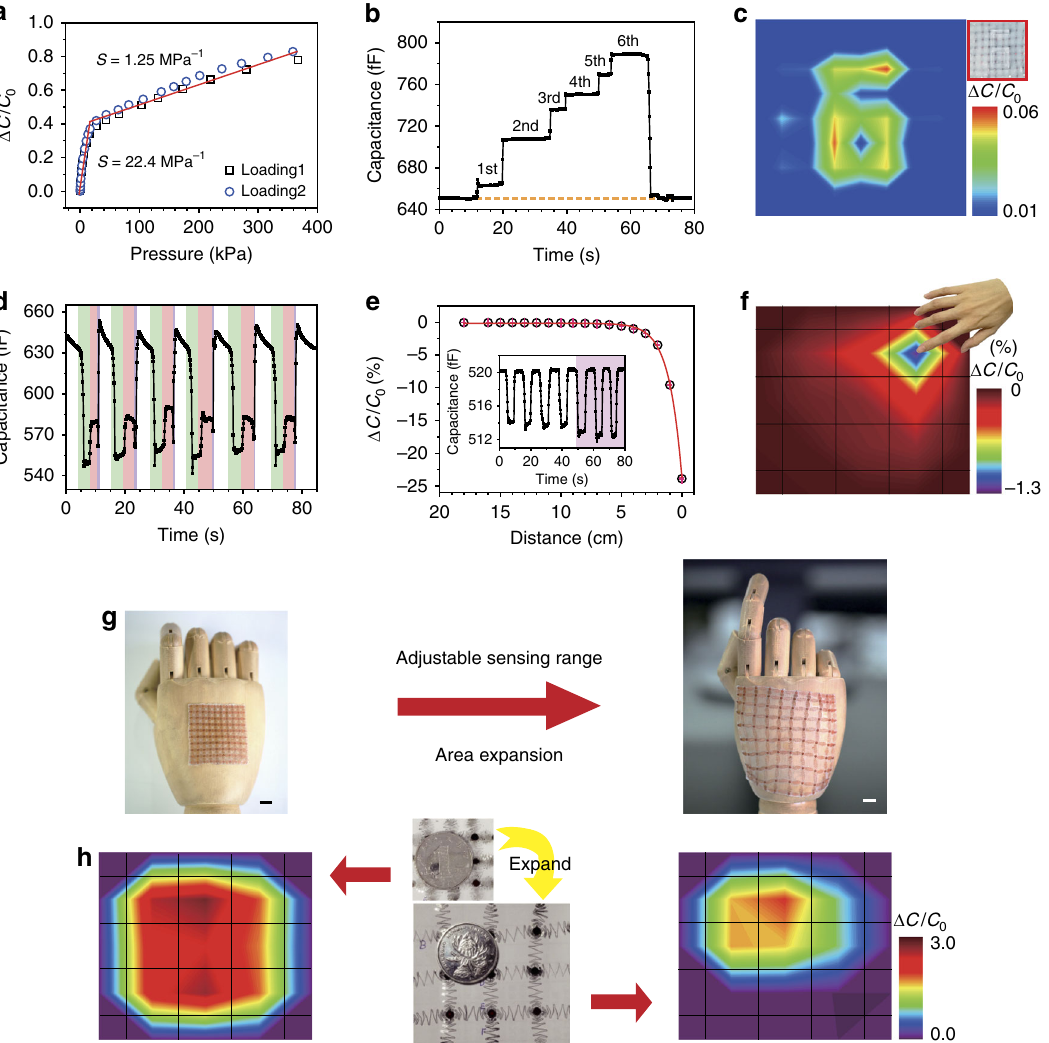
Fig. 4 Pressure and proximity sensing performances and area expansion. a Capacitance response to various pressures for two consecutive load tests. b Real-time small-pressure recording during the sequential application of six water droplets to the sensor; the corresponding pressure is 7.3 ± 1.2 Pa. c Pressure mapping of a number “ 6 ” stamped on the pressure sensor array with a pressure of 8 kPa. d Capacitance changes from a fi nger cyclically approaching the device (green, from a distance of approximately 1 cm), pressing it (pink) and moving away (white). e The relative capacitance change reduces with the decreasing distance of an approaching fi nger. The inset shows the capacitance difference as a fi nger repeatedly approaches the device. f Proximity detection of a hand and identi fi cation of its position. g Schematic illustration of an SCMN as an arti fi cial electronic skin on a hand, showing sensing adjustability and expandability (scale bar: 1 cm). h Pressure mapping before and after the 300% expansion of an SCMN; the position of the pressure load is also identi fi ed after